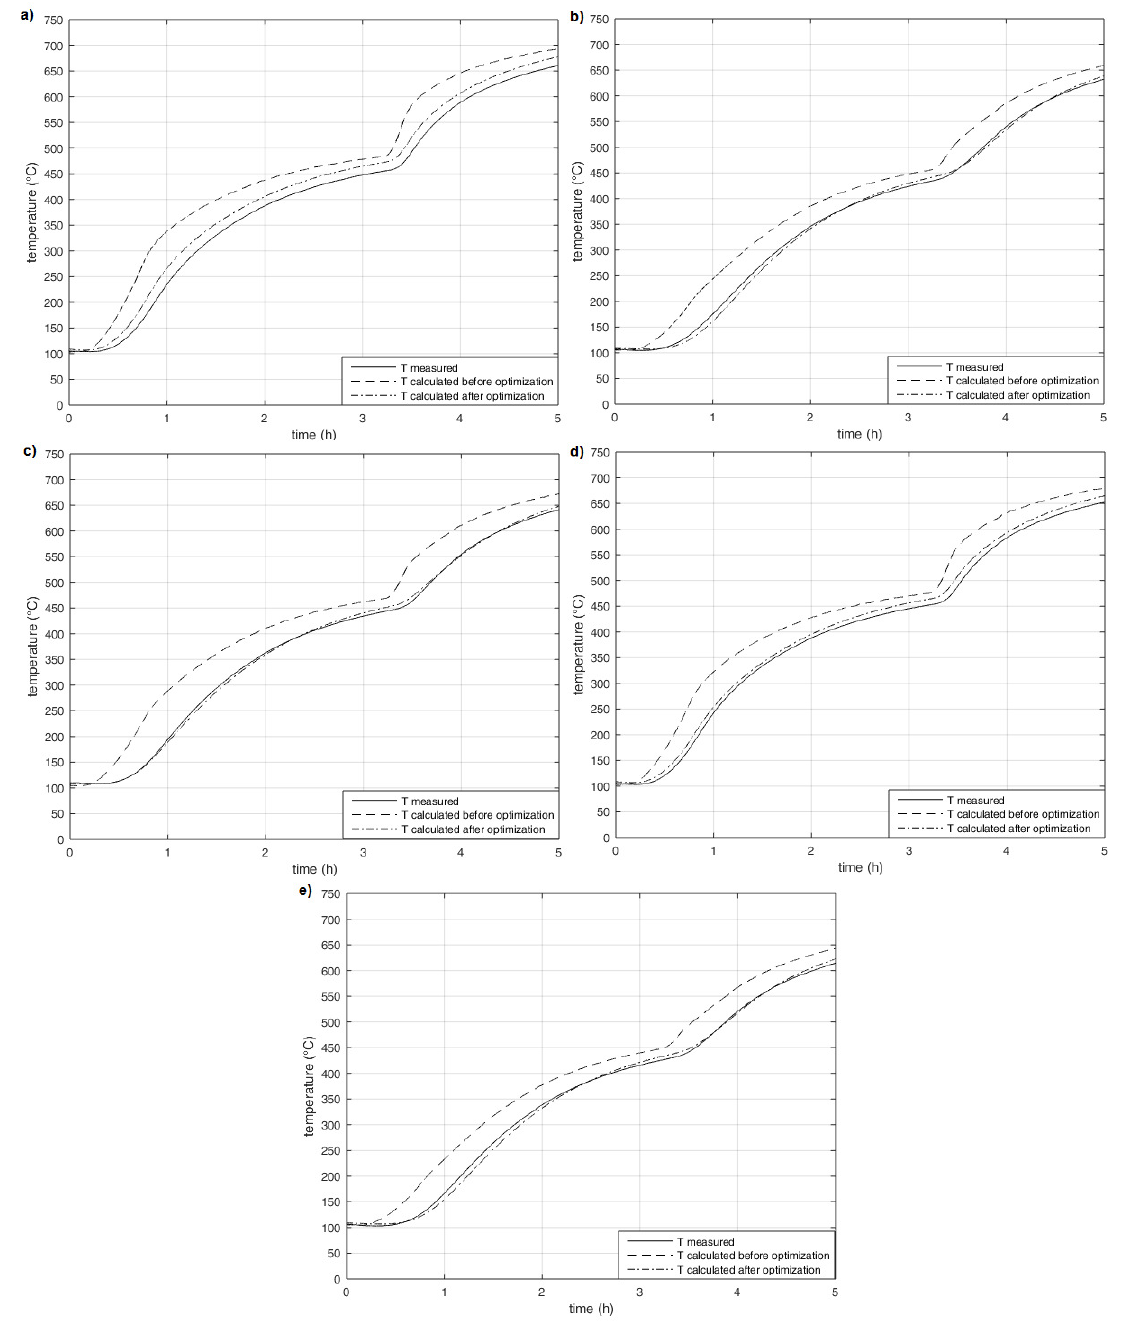
Figure 12. Comparison of direct measured temperature (T measured) to indirect measured temperature before (T calculated before optimization) and after (T calculated after optimization) optimization for temperature ( a ) T 1 , ( b ) T 2 , ( c ) T 3 , ( d ) T 4 , and ( e ) T 5 of laboratory measurement